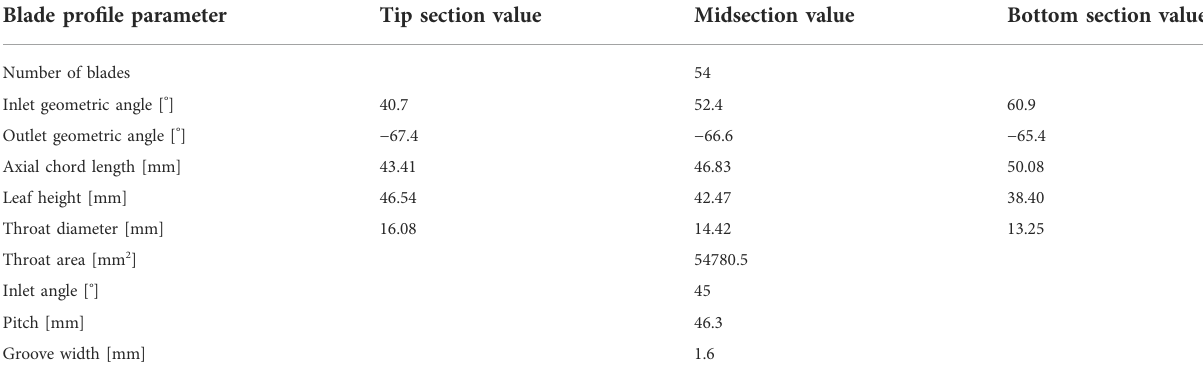
TABLE 1 Geometric parameters of different sections of the model. Blade pro fi le